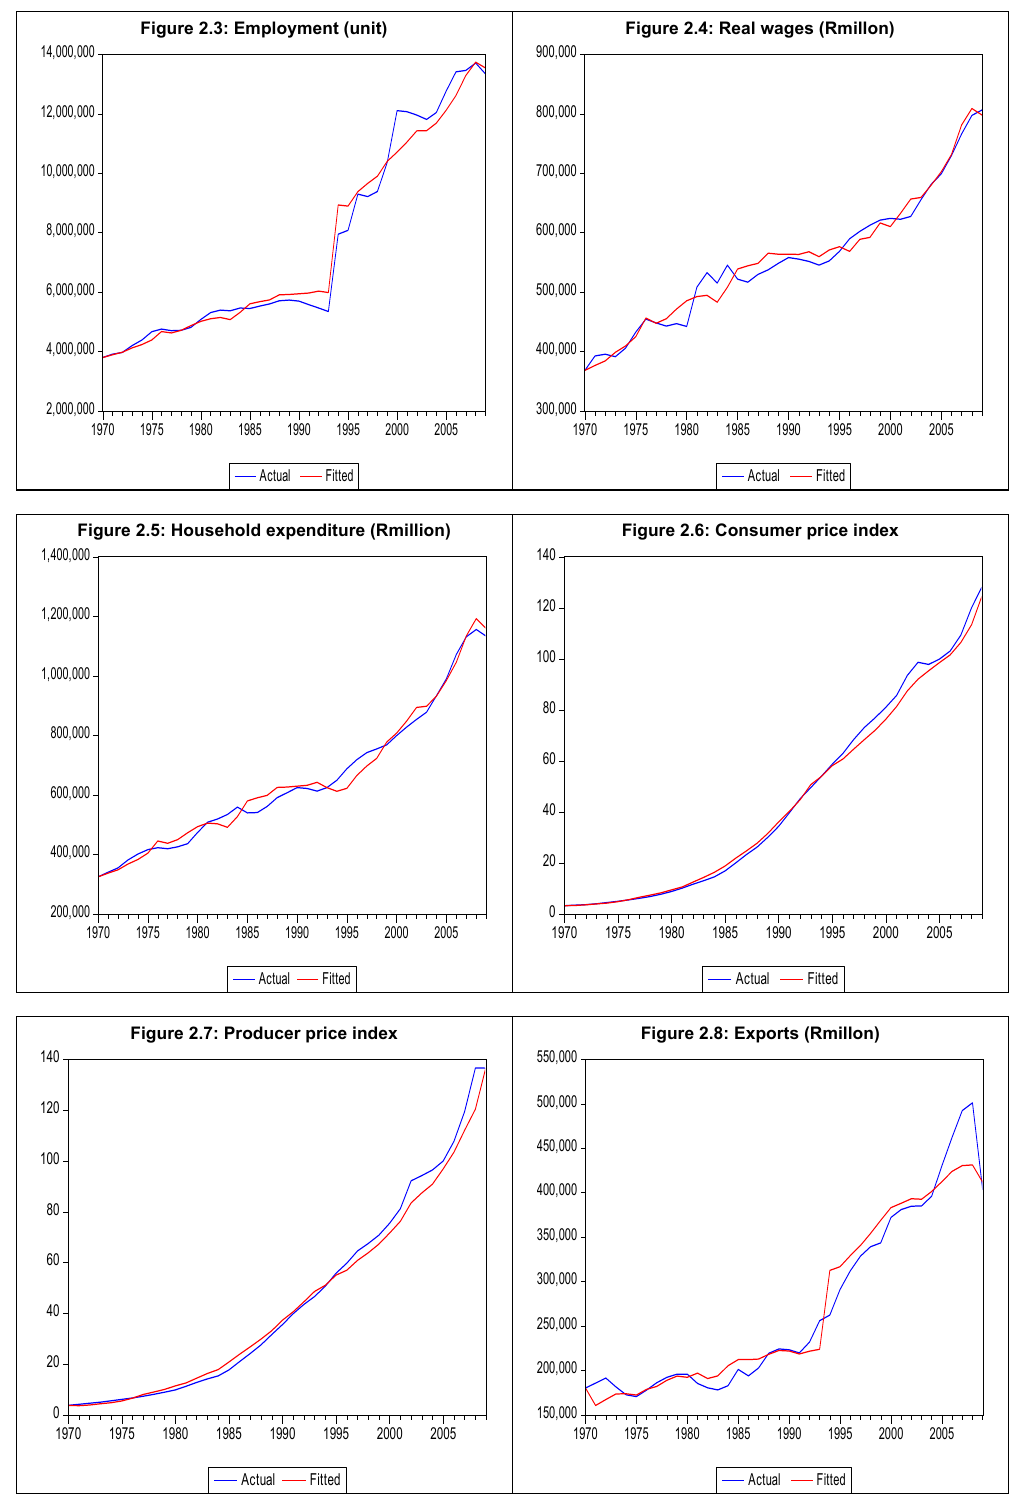
Figure 2.3: Employment (unit) Figure 2.4: Real wages (Rmillon)